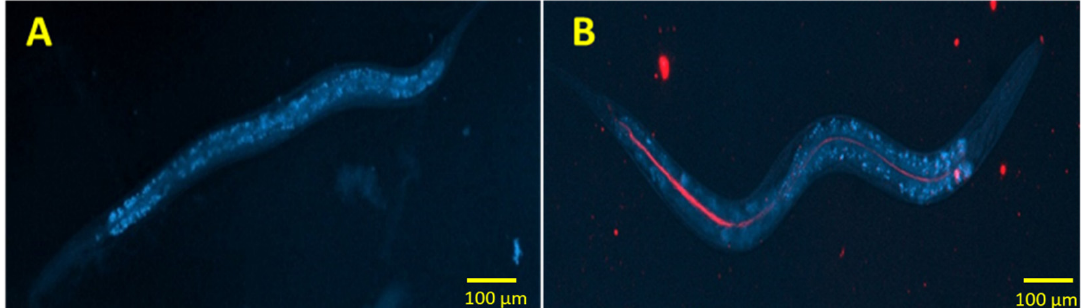
Figure 7. Fluorescence micrographs of C. elegans . ( A ) self-fluorescence of a worm under DAPI filter. ( B ) Worm fed with fluorescently-tagged nanoparticles.